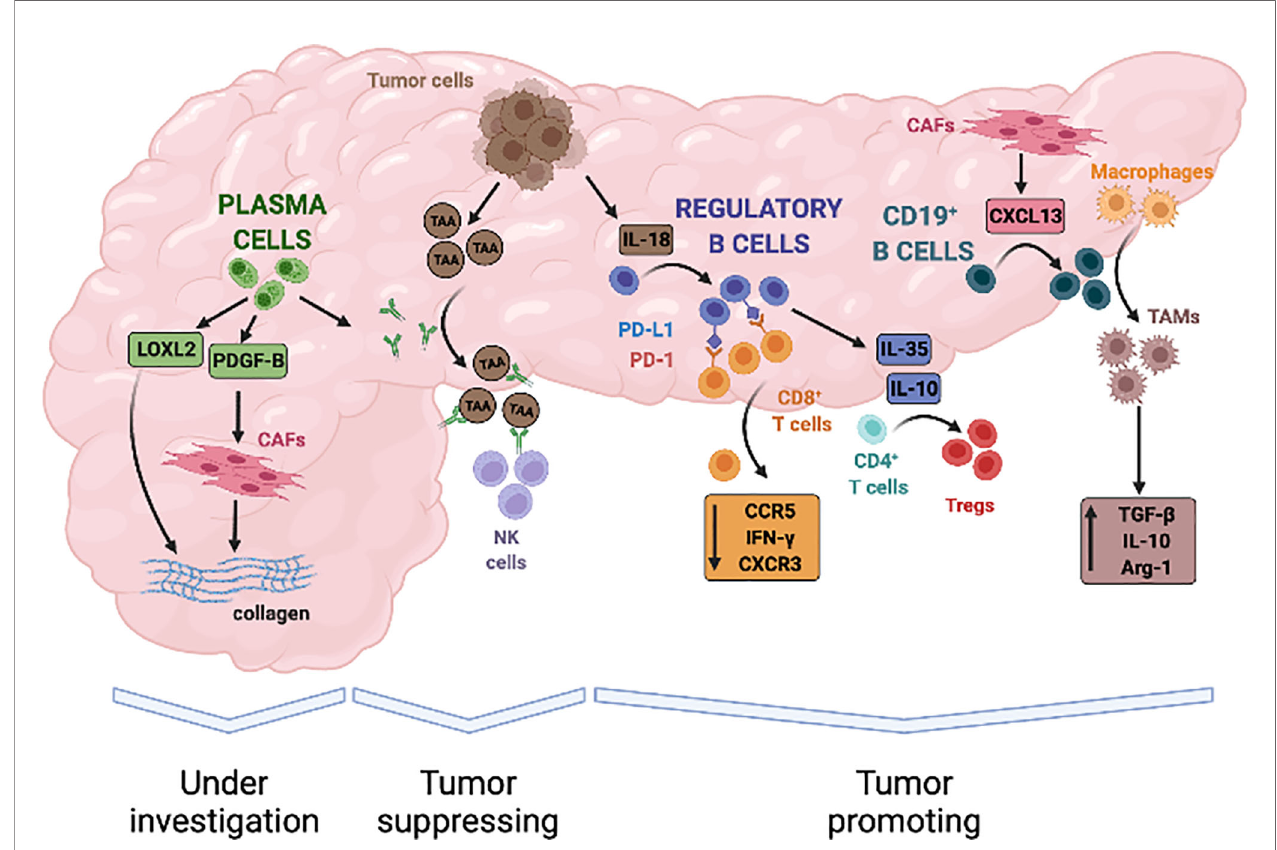
FIGURE 2 | Evidence-based contribution of B lymphocytes to progression of pancreatic adenocarcinoma. B cells in fi ltrate PDAC in response to the release of local chemokines, such as CXCL13, and can contribute to both tumour promotion and tumour suppression through a variety of mechanisms. Tumour derived IL-18 can induce B lymphocytes with a regulatory phenotype that inhibit anti-tumour cytotoxic T cells responses. B-regulatory cells also secrete immune-modulatory cytokines such as IL-35 and IL-10 that induce T-regulatory cells (Tregs), stimulate tumour proliferation, and promote local angiogenesis. In addition, B-regulatory cells can recruit monocytes to tumour site and foster their differentiation into TGF- b and IL-10 producing M2 macrophages, thus further amplifying immune-evasive strategies and impairing cytotoxic responses. On the other hand, tumour-suppressive activity of B-cells in PDAC has not been clearly established but in-vitro studies suggest that it might depend on the production of autoantibodies against tumour associated antigen (TAA), engagement of natural killer cells (NK cells), and antigen dependent cell-mediated cytotoxicity (ADCC). Finally, plasma cells can sustain activation of the tumour stroma through the secretion of proliferative stimuli for cancer- associated fi broblasts (CAFs), such as PDGFB, and the production of enzymes that regulate extracellular matrix stiffness, such as LOXL2. Whether these properties ultimately exert tumour suppressive or tumour promoting effects is currently under